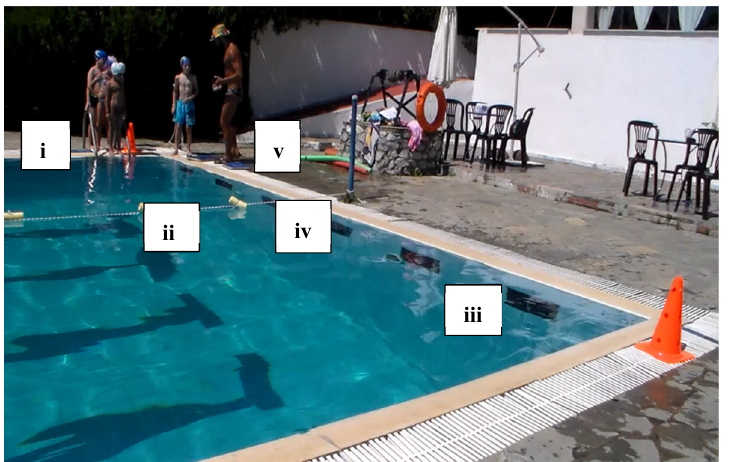
Figure 1. Skills and Performance test. i = Start: Entrance in the pool, ii = Sink 1: Dive under the pool’s lane for first time, iii = Swim: Swim until the opposite side of the pool, iv = Sink 2: Dive under the pool’s lane for second time, v = Kicks’ Time: Took the kickboard for the 35 m of free kick.